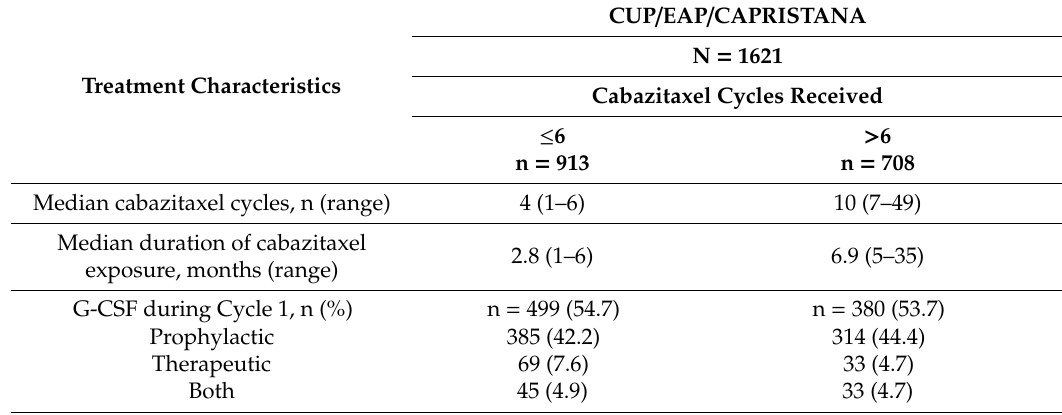
Table 1. Cabazitaxel treatment and granulocyte-colony stimulating factor (G-CSF) use according to the number of cabazitaxel treatment cycles received across the CUP/EAP and CAPRISTANA studies.